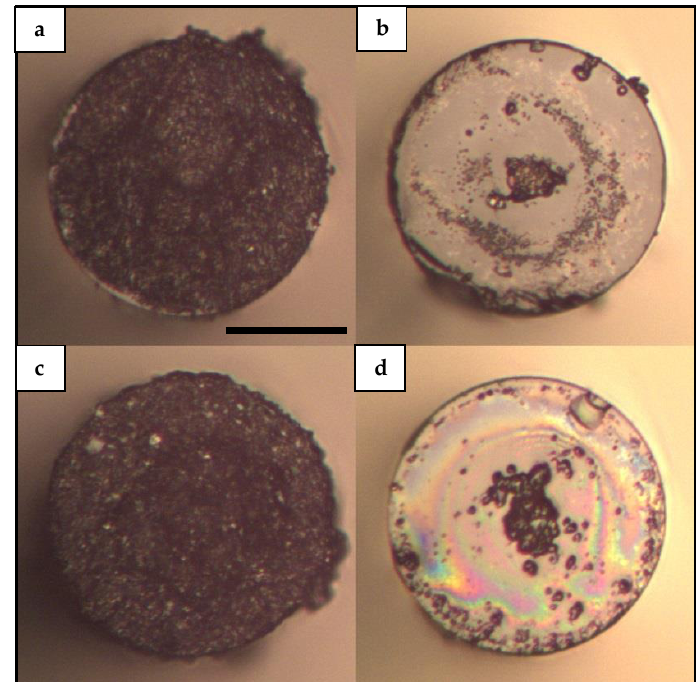
Figure 3. Laser-induced deposition of CNTs onto MMI fiber tip using methanol-based aqueous solutions: ( a ) Deposition performed with the M-SW sample; ( b ) Deposition performed with the M-SW-PVP sample; ( c ) Deposition performed with the M-MW sample; ( d ) Deposition performed with the M-MW-PVP sample. A 980 nm laser is used at 88.3 mW to obtain the laser-induced depositions in all cases shown in this figure. The images were taken using an optical microscope with a 20 × microscope objective. The reference bar in panel ( a ) corresponds to 60 μ m.